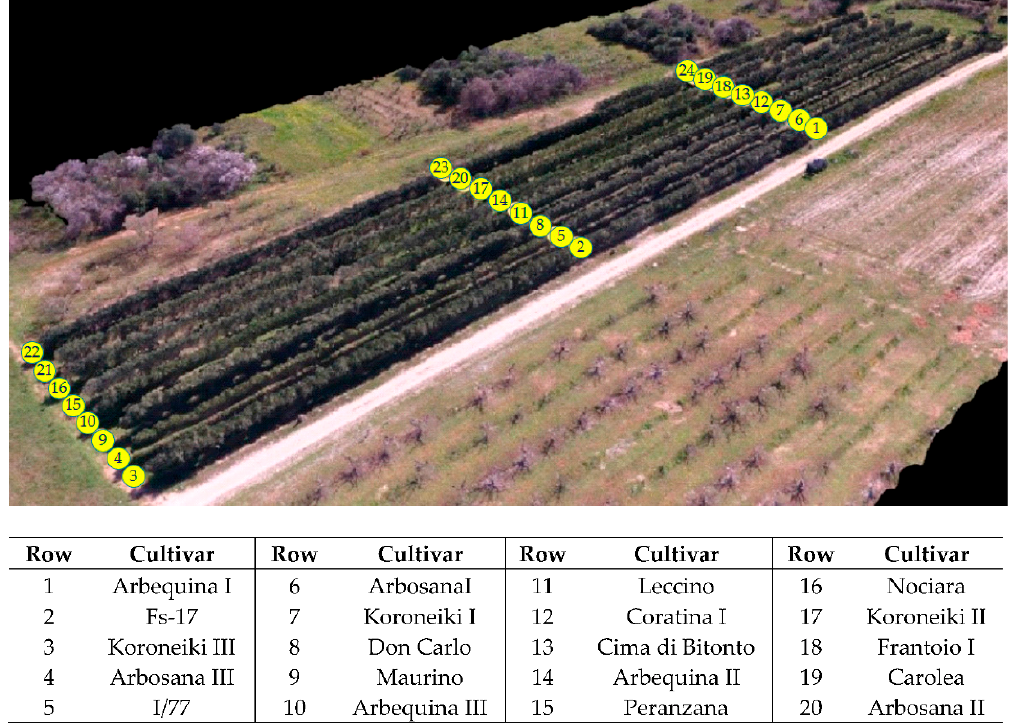
Figure 3. Experimental olive orchard, row numbers, and cultivars.